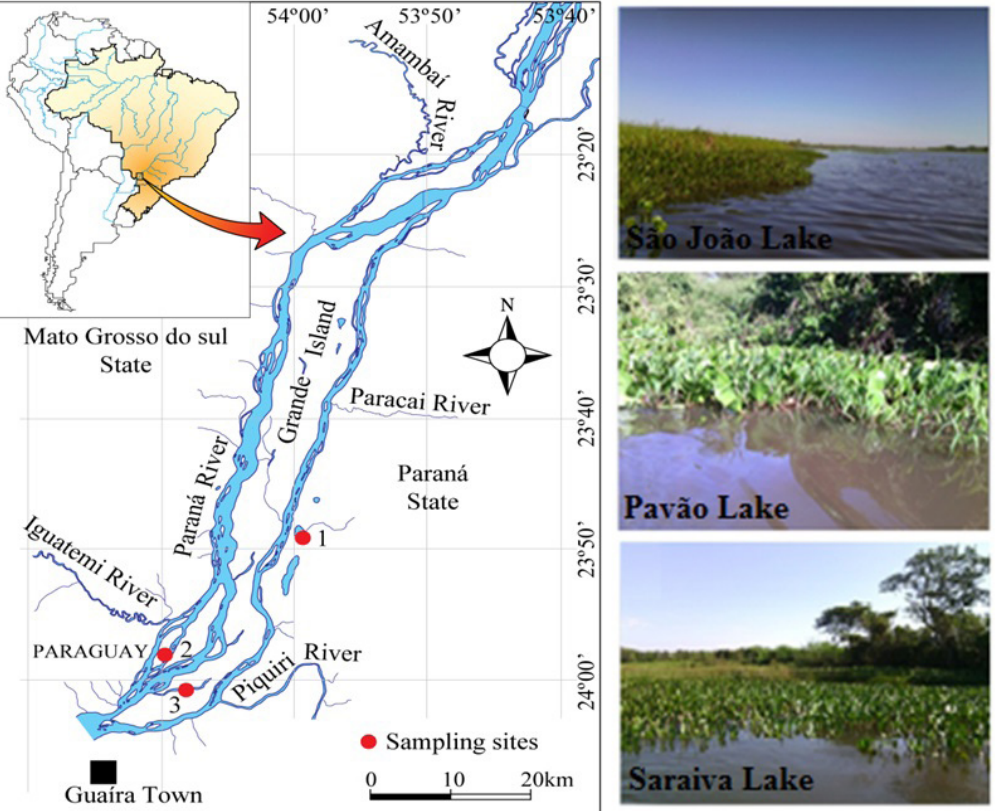
Figure 1. Upper Paraná River floodplain and location of the sampling